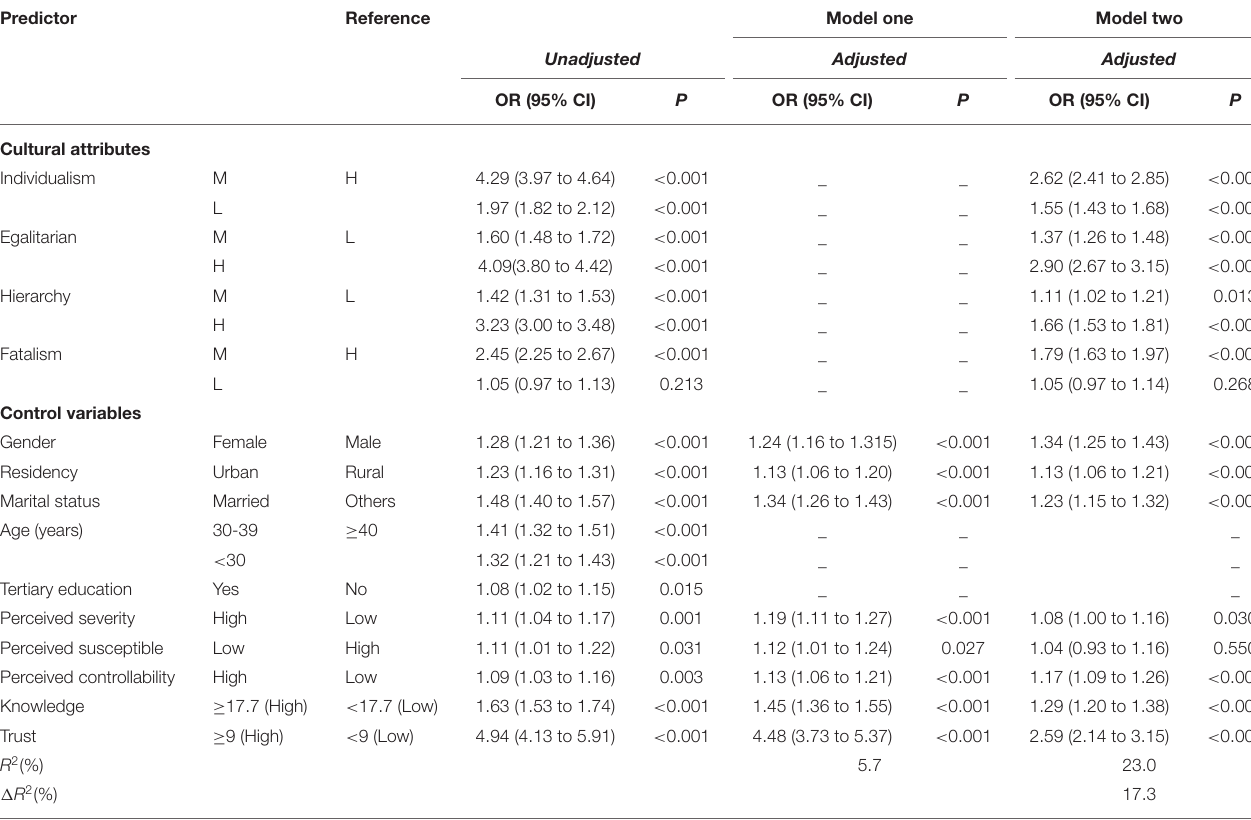
TABLE 3 | Predictors of protective behaviors–results from logistic regression models.